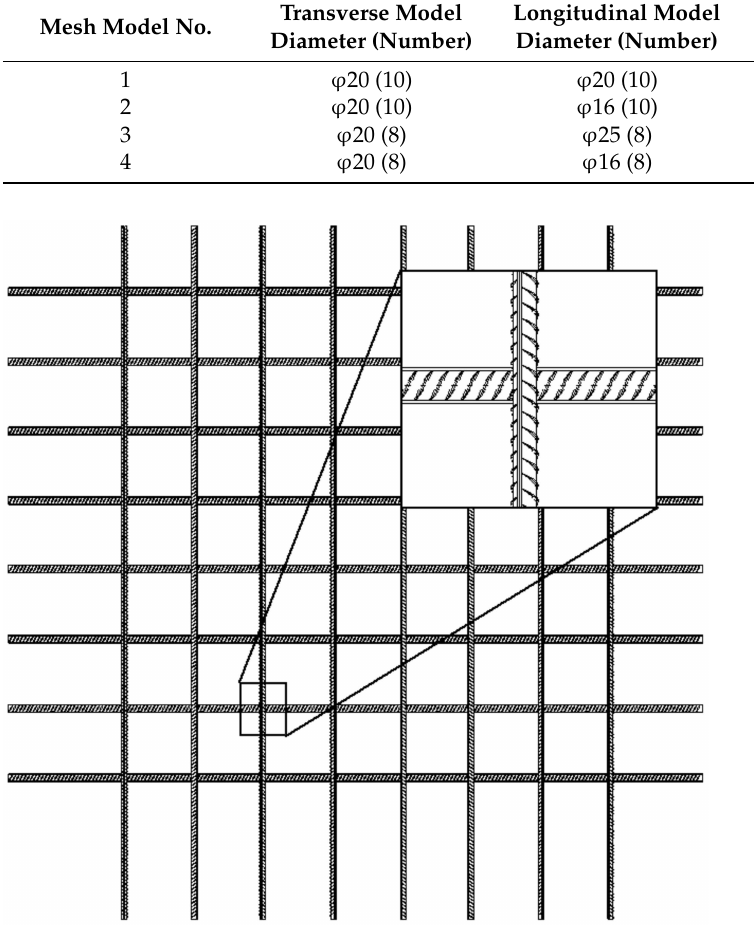
Figure 3. Rebar mesh